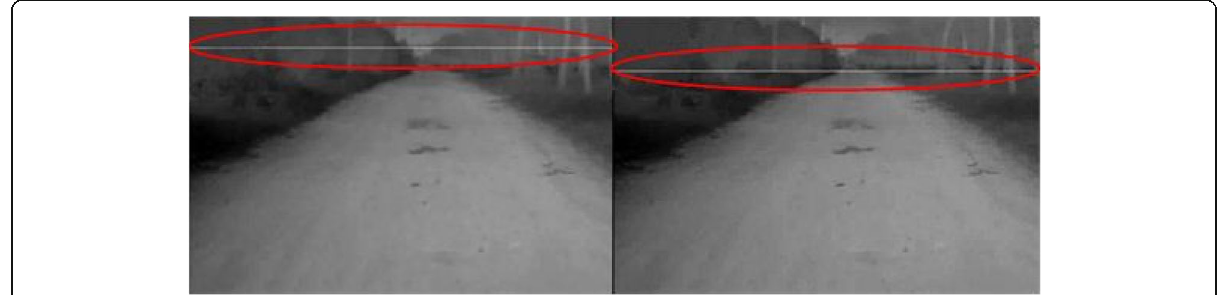
Fig. 19 Result comparison of vanishing line detection. a By Sobel operator and b by normal